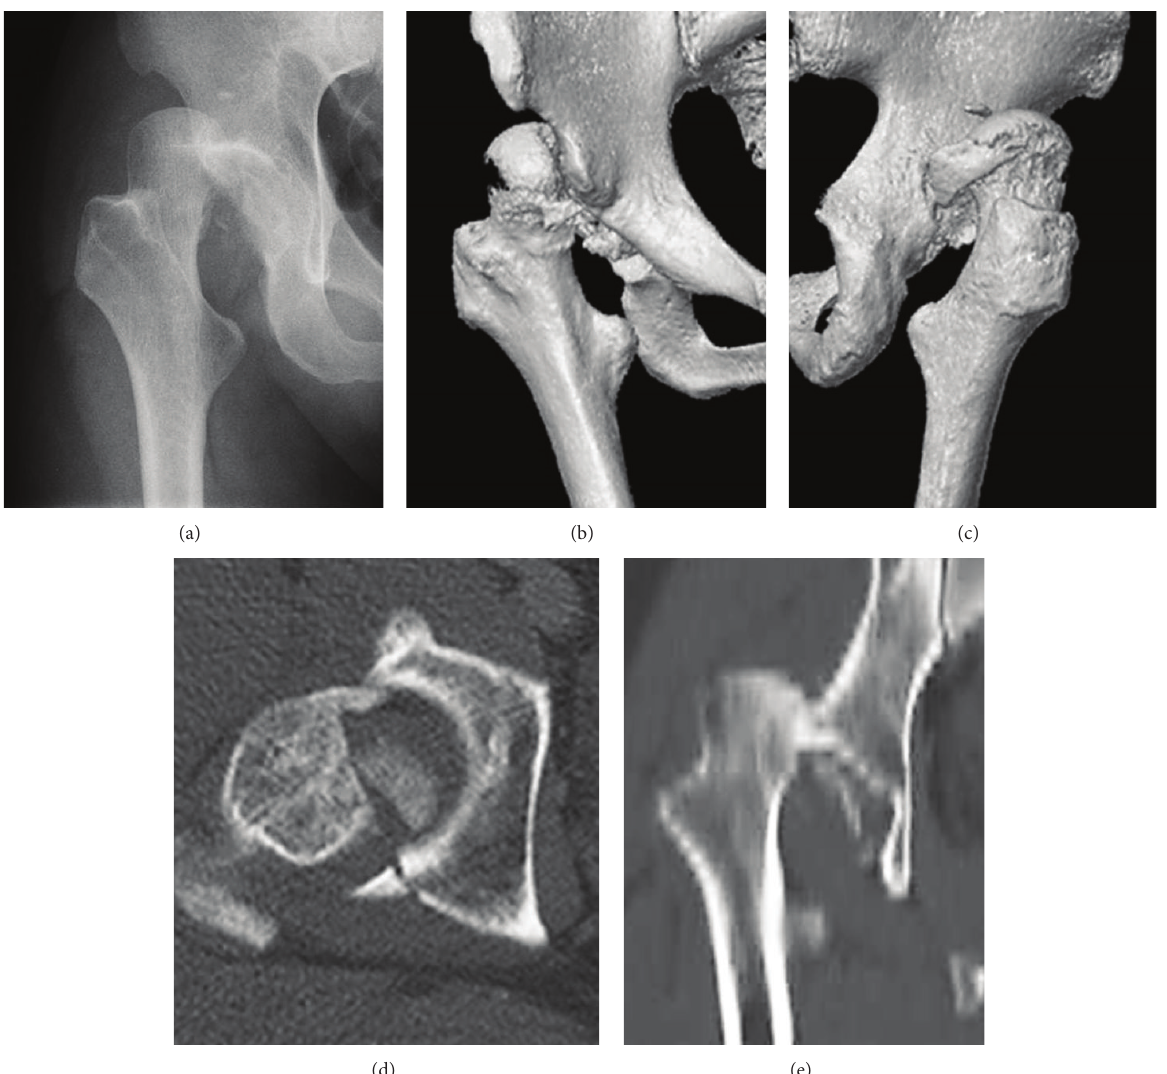
Figure 1: Case 1. A 45-year-old man with Pipkin type-IV fracture of the right hip with posterior dislocation of the femoral head. (a) Anteroposterior X-ray image of the right hip at the injury. (b) Anteroposterior three-dimensional computed tomography showing dislocation and fracture of the femoral head. (c) Posteroanterior three-dimensional computed tomography showing displacement of the posterosuperior wall and rim. (d) Axial computed tomography showing fracture of the femoral head and posterior wall of the acetabulum. (e) Coronal computed tomography showing dislocation and fracture of femoral